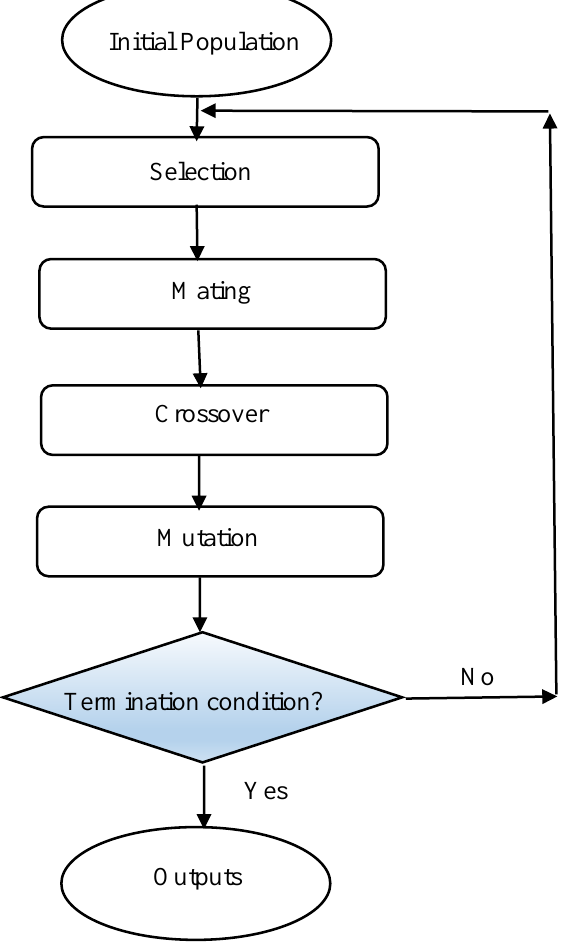
Figure 3. Flowchart of genetic algorithm (GA) optimization method.